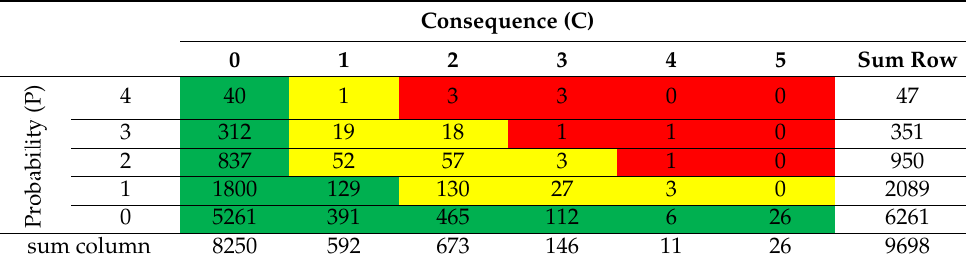
Table A3. Risk matrix based on flow only at time 17.00.